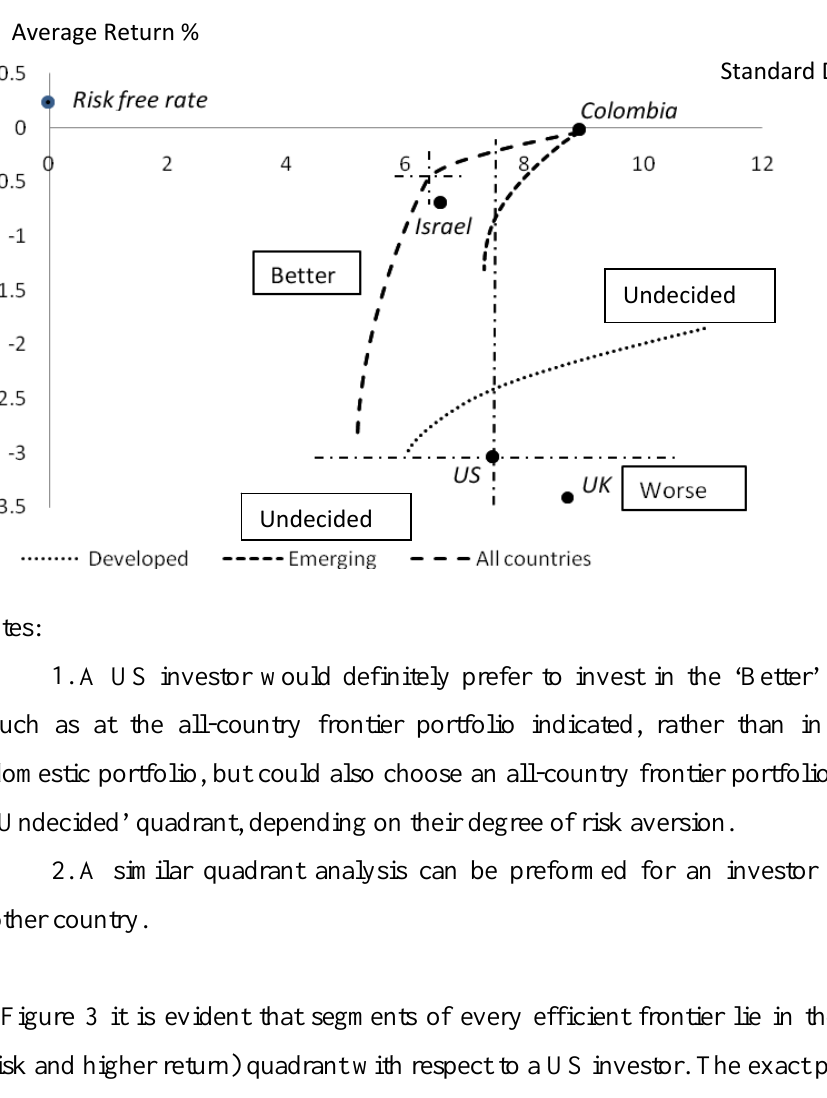
Figure 3. Benefits from International Diversification – US